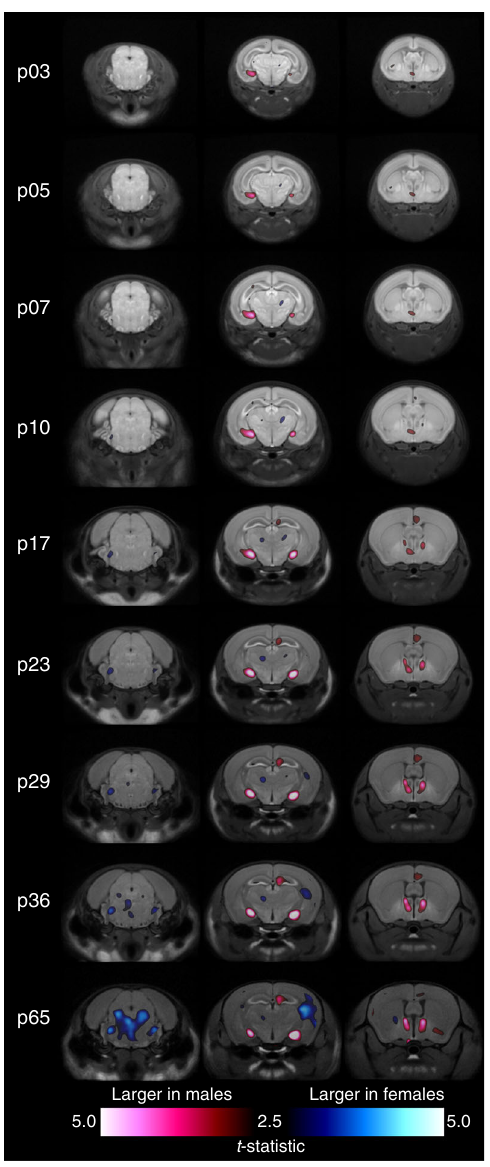
Fig. 5 Expansion of neuroanatomical structures in males and females over time. Each column follows a coronal cross-section of the developing brain through the nine experimental time points with red regions indicating areas relatively larger in males and blue regions indicating areas relatively larger in females. Nine age-centered linear mixed-effects models were fi t to the data, one for each experimental time point. Each model had identical predictors of sex and age, however the age terms were translated such that they were 0 at the time point of interest. For each time point and corresponding age-centered model, the average brain at the time point was overlaid with the t -statistics map associated with the main effect of sex. Statistics are thresholded to 10% FDR in the model centered at p65. Regions relatively larger in males predominate the brain in pre-puberty life (as shown by the second and third image columns). Post-puberty however, regions larger in adult females begin showing